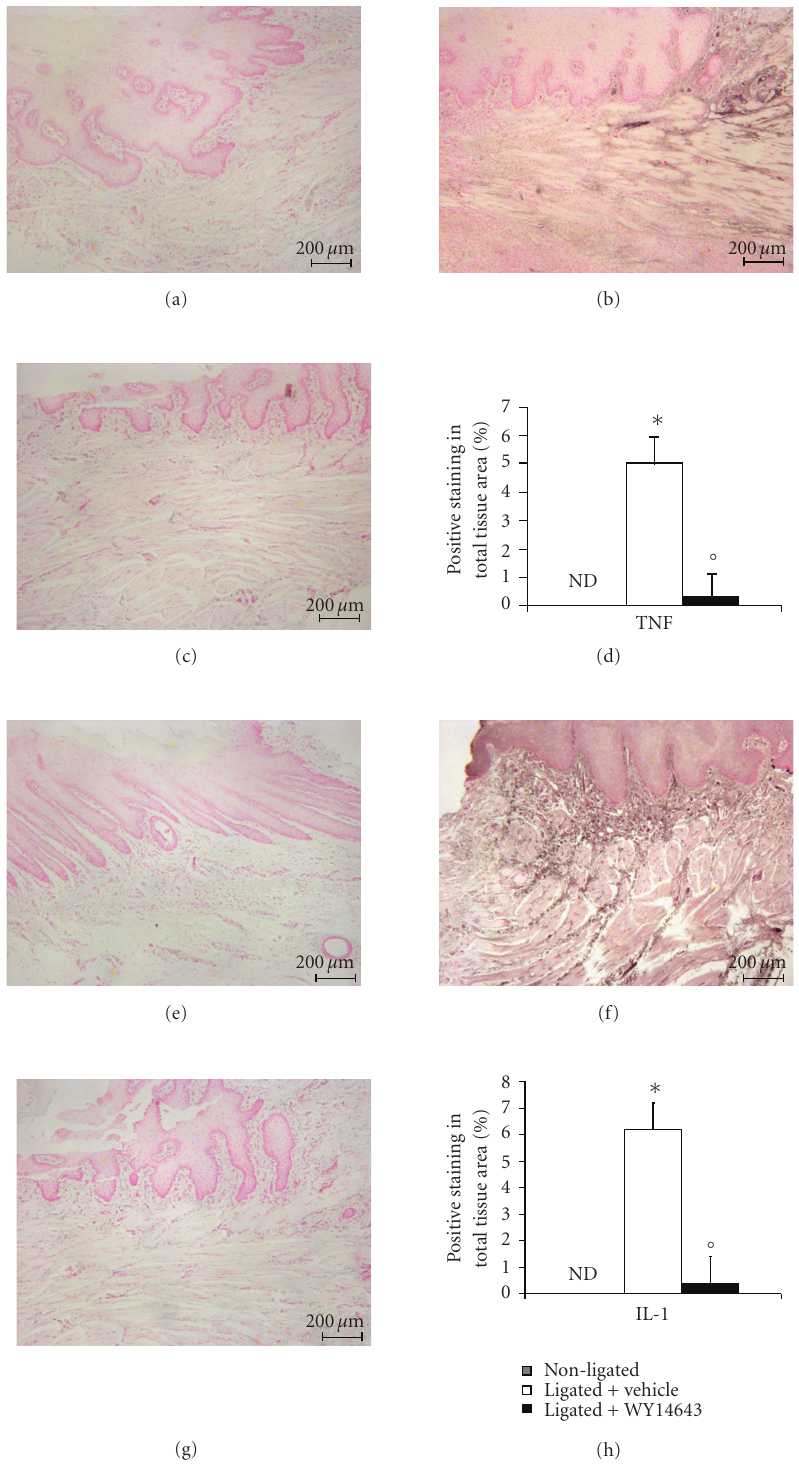
Figure 3: E ff ect of WY14643 on cytokines expression. Immunohistochemical analysis of gingivomucosal tissues from the contra lateral side obtained from vehicle-treated rats did not reveal any immunoreactivity for TNF- α and IL-1 β (a, e). Positive staining for for TNF- α and IL-1 β were found in the gingivomucosal tissues from ligature operated rats (b, f) after ligature. WY14643 treatment significantly reduced the degree of positive staining for TNF- α and IL-1 β (c, g). Densitometry analysis of immunocytochemistry photographs (d, h); n = 5 photos from each samples collected from all rats in each experimental group) for TNF- α and IL-1 β from gingivomucosal tissue was assessed. The assay was carried out by using Optilab Graftek software on a Macintosh personal computer (CPU G3-266). Densitometry data are expressed as % of total tissue